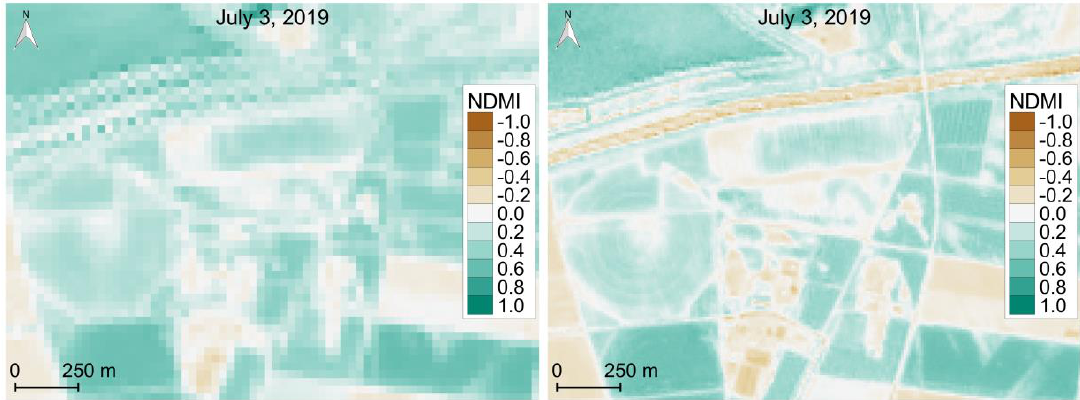
Figure 12. Normalized Difference Moisture Index (NDMI) maps derived from Landsat-8 with 30 m resolution (left) and from Sentinel-2 with 10 m resolution from 3 July 2019 near-infrared (NIR) and shortwave infrared (SWIR1) images.